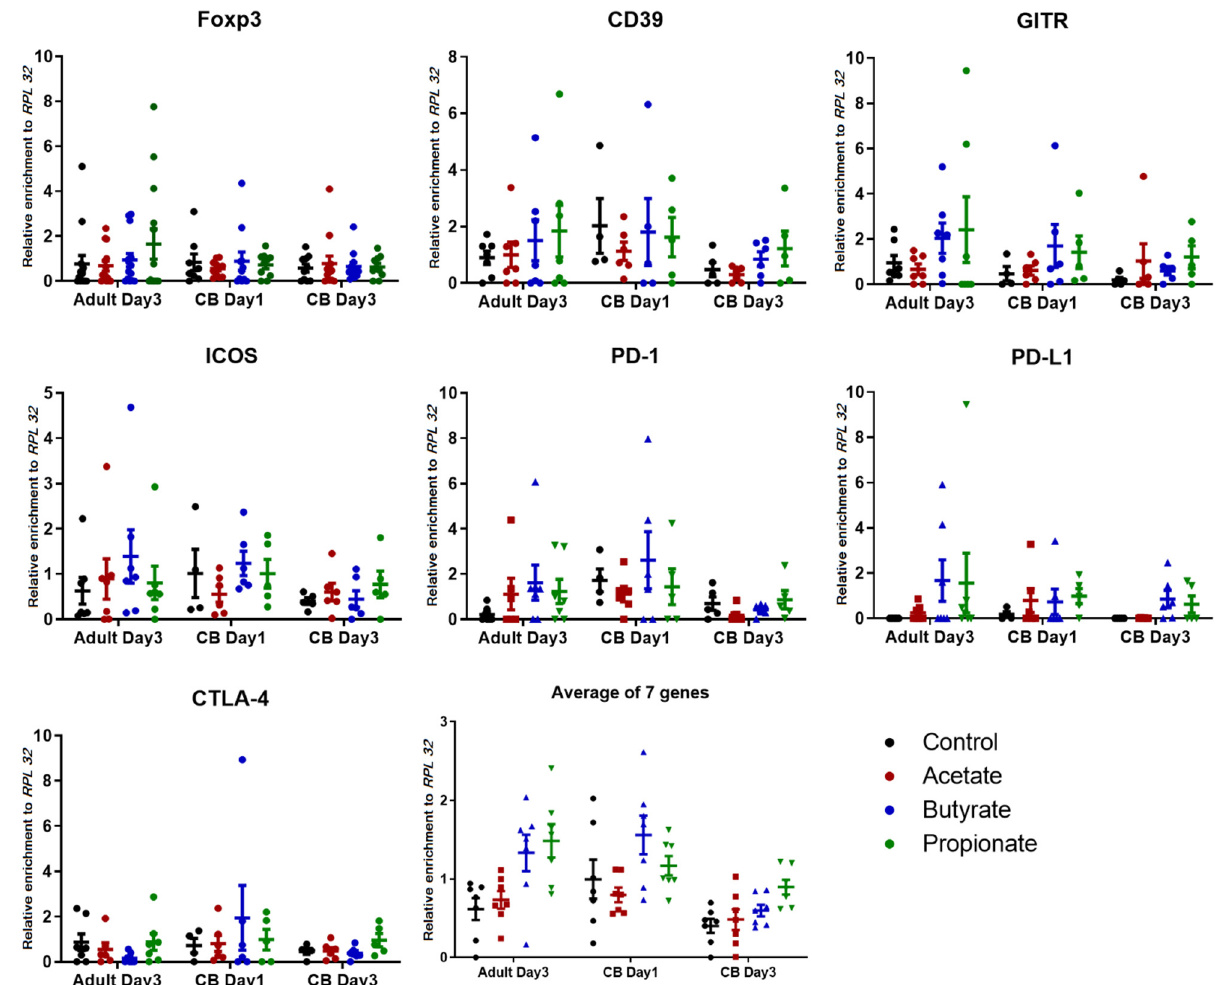
Figure 6. Histone H4 pan-acetylation status at the transcription-controlling regions of regulatory T cell (Treg) genes. Histone 4 acetylation levels at seven Treg loci given as the relative enrichment to ribosomal protein L32 ( RPL32 ) in human adult (n = 7; peripheral blood) or newborn (n = 6; cord blood, CB) naïve CD4 + non-Treg cells differentiated toward iTreg phenotype in the presence or absence of short-chain fatty acids (SCFAs). Adult-derived cells were harvested on day 3, and CB-originating cells on days 1 and 3 (see Supplementary Figure S1). H4 acetylation was analyzed by a chromatin immunoprecipitation–quantitative polymerase chain reaction (ChIP-qPCR) assay. The data are expressed as means with the standard error of the mean (SEM). There was no statistical significance using the Friedman test with Dunn’s multiple comparisons (post hoc).